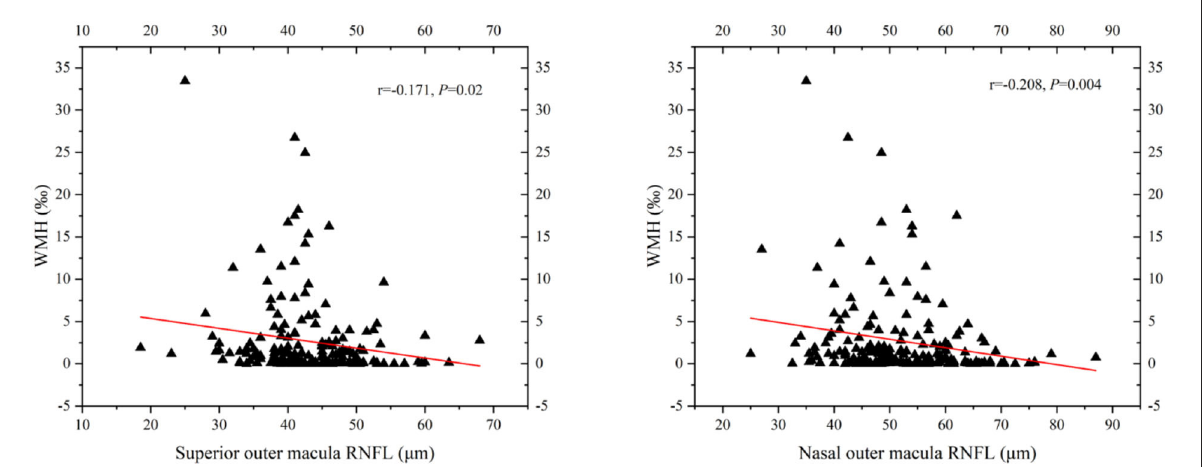
FIGURE5 Scatterplot demonstrating the relationship between RNFL thickness and WMH volume ( ‰ ). WMH, white matter hyperintensity; RNFL, retinal nerve fiber layer. WMH volume had significant negative correlation with superior outer RNFL thickness ( r = − 0.171, P = 0.02) and nasal outer RNFL thickness ( r = − 0.208, P =